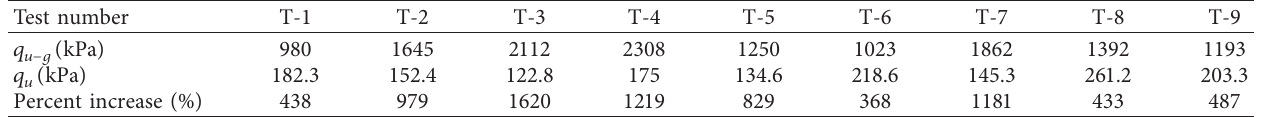
Table 4: Compressive strength variation amplitude of loess before and after grouting.